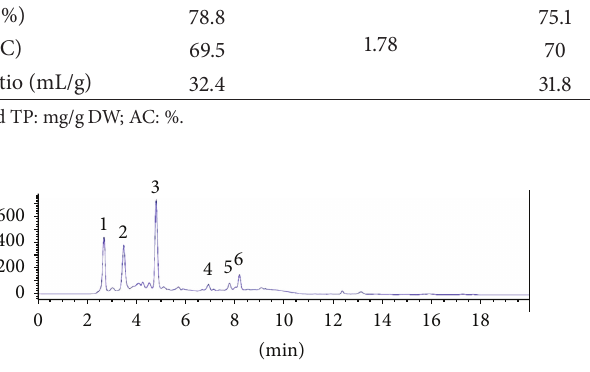
Figure 5: UHPLC chromatogram of Pandan extract. Identified compoundsaregallicacid(1),catechin(2),caffeicacid(3),myricetin (4), luteolin (5), and quercetin